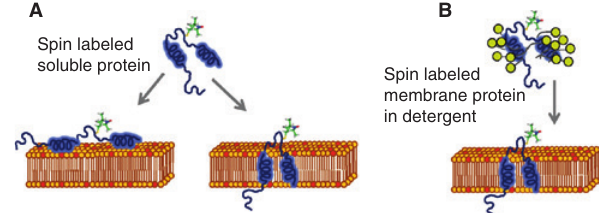
Figure 2: Three cases of protein-membrane association in vitro . (A) The protein is expressed and folded in soluble form, but in the presence of lipid membranes it can either bind to the membrane periphery (left) or transverse the membrane (right). Often binding to membrane involves large structural rearangenents. (B) The protein is expressied and folded on the cellular membranes, then it is puri- fied by detergent solubilization and reconstituted in lipid bilayers for in vitro functional and structural studies. For EPR studies, in case (A) the proteins are spin-labeled in buffer solution, whereas in (B) the proteins are spin-labeled in detergent-bound form.